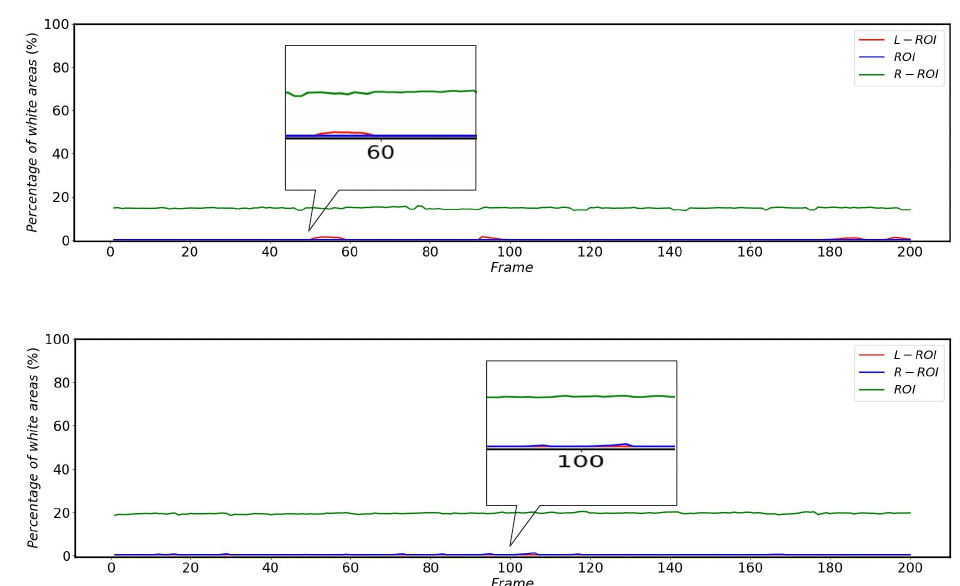
Figure 22. Change in the percentage of white areas in the vertical projection of different areas of HSR-A ( top ) and HSR-B ( bottom ) when the HSR is operated without external